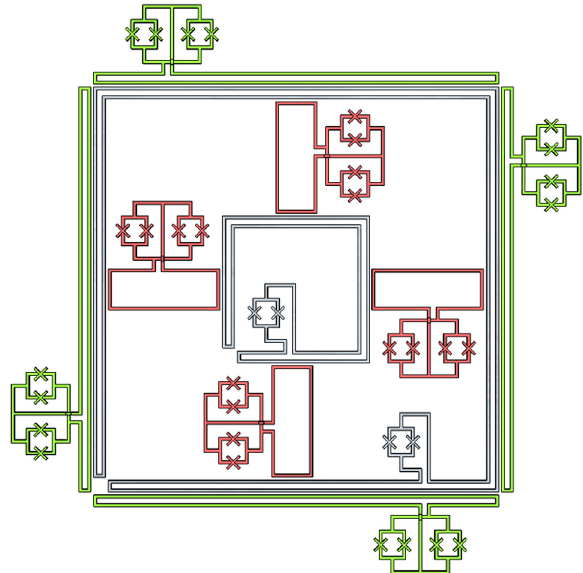
Fig. 2 Drawing of the circuit which implements the low energy spectrum of a four-body coupler. The 4-logical qubits appear as the 4 ( green ) circuits on the perimeter, with a large loop ( gray ) coupling them together. Further in is a set of 4 ancilla qubits ( red ), which in turn themselves are coupled by an inner most loop ( gray ), which counteract the couplings induced from the outer loop. Note that the qubits are compound-compound Josephson junction circuits, while the couplers are simply